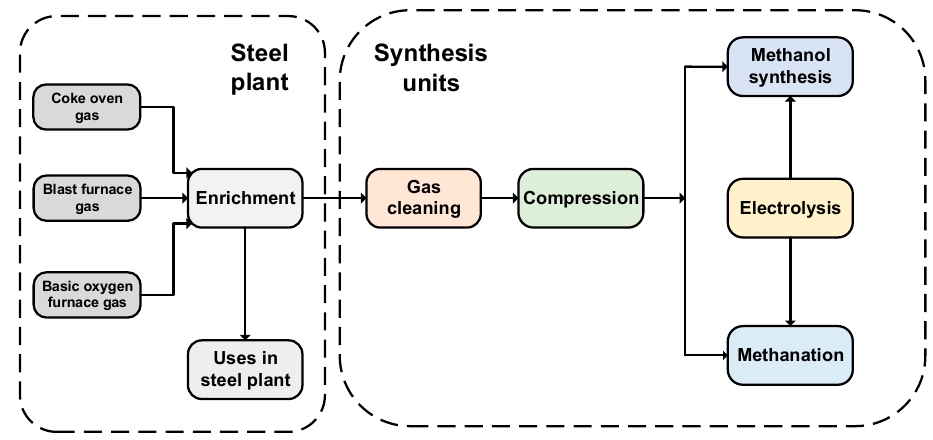
Figure 5. Integration of synthesis units into steelworks.